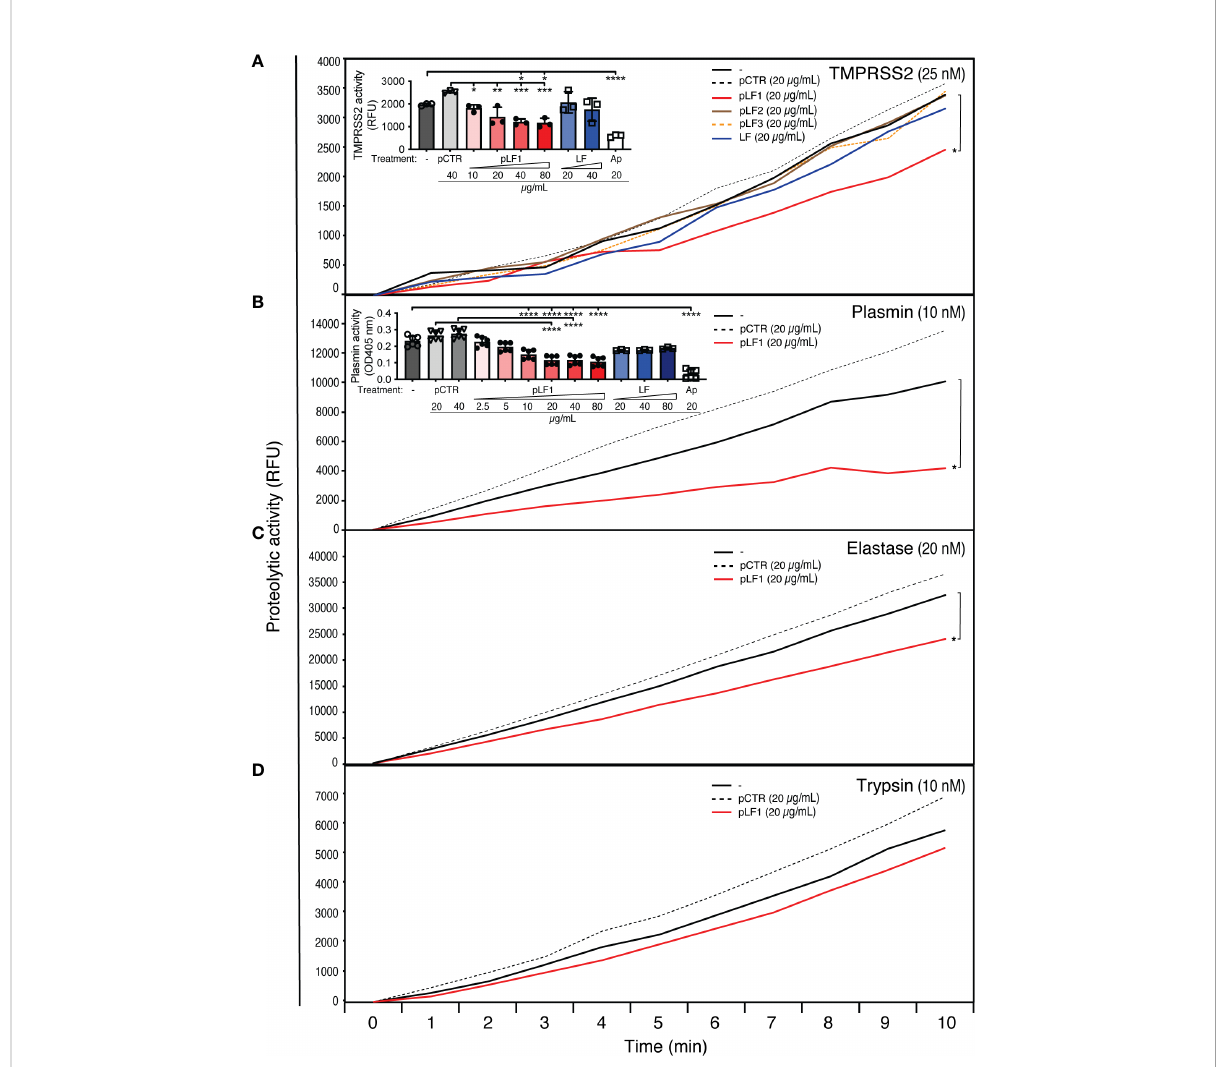
FIGURE 1 Effect of LF and the LF-derived peptides pLF1-pLF3 on the activity of serine proteases. Proteolytic activities of puri fi ed TMPRSS2 (A) , plasmin (B) , elastase (C) , and trypsin (D) were measured with or without peptides pLF1, pLF2, pLF3, LF or the control peptide pCTR at 37°C in Tris-HCl buffer using the fl uorogenic substrate Boc-Gln-Ala-Arg-AMC. The reaction was monitored using an ELISA reader for the indicated time intervals. The insets in (A) and (B) show concentration-dependent inhibition of TMPRSS2 and plasmin activities by pLF1 but not by LF after 30 min and 4 h, Values of p*<0.05, p**<0.005, p***<0.0005, p****<0.0001 (as indicated) were considered to be signi fi cant or highly signi fi cant,